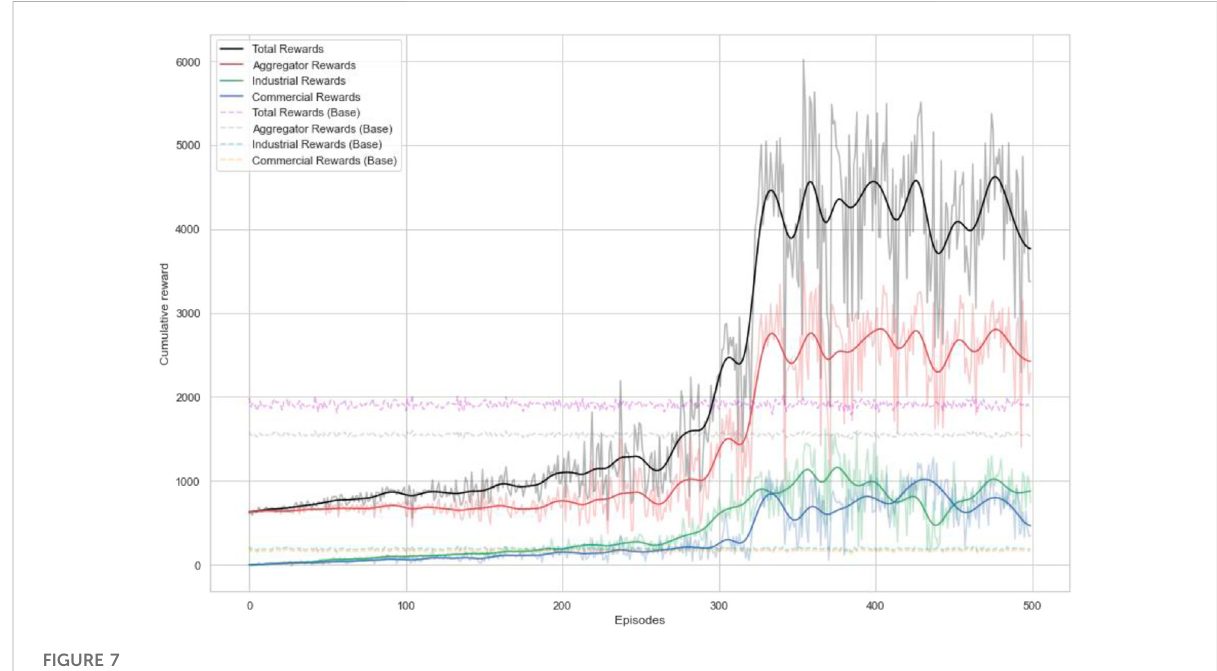
FIGURE 7 Performance of RL agents.